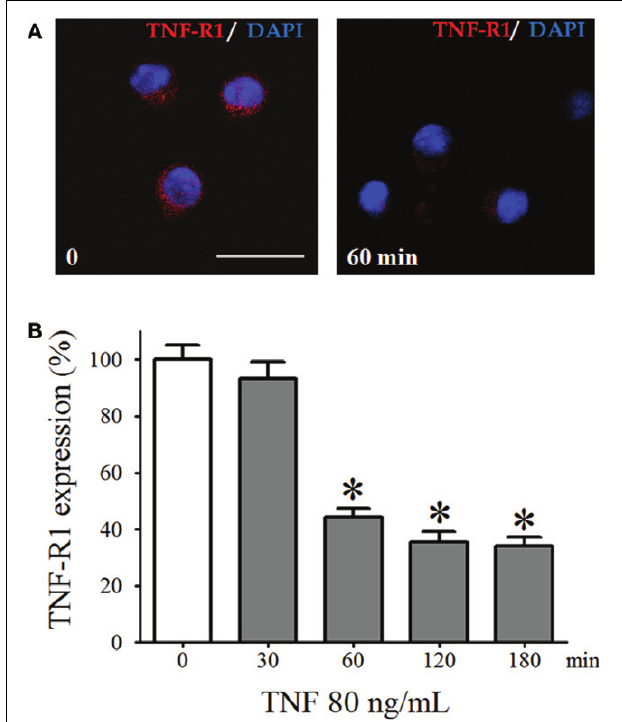
FIGURE 3 |TheTNF-R1 expression in dispersed pinealocytes. (A) Representative immunocytochemistry images of cultured pinealocytes showing the constitutive expression ofTNF-R1 (stained in red, left-hand side). Incubation withTNF (80ng/mL) for 60min reduces the detection of TNF-R1 (right-hand side). Blue staining represents fluorescent nuclei stained using DAPI. (B) Quantification of the fluorescence of pinealocytes stimulated (gray bars) or not stimulated (white bars) withTNF (80ng/mL) for 30–180min. Data are expressed as the mean ± SEM; n = 4 independent cultures. In each well, we counted 21 cells in three different, randomly chosen fields. * p < 0.05 vs. noTNF. Scale bar = 20 μ m.